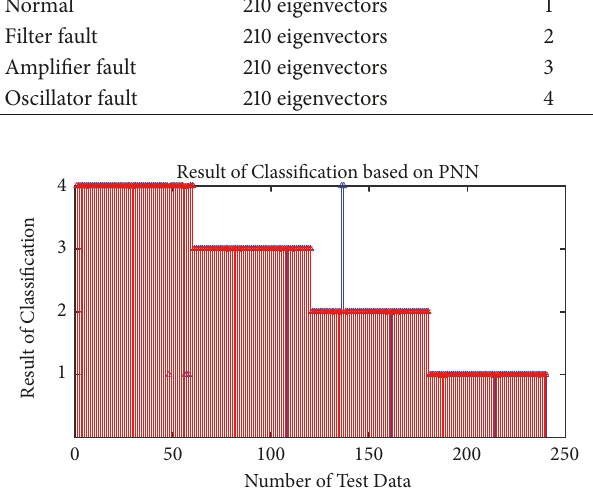
Figure 10: Result of Classification based on